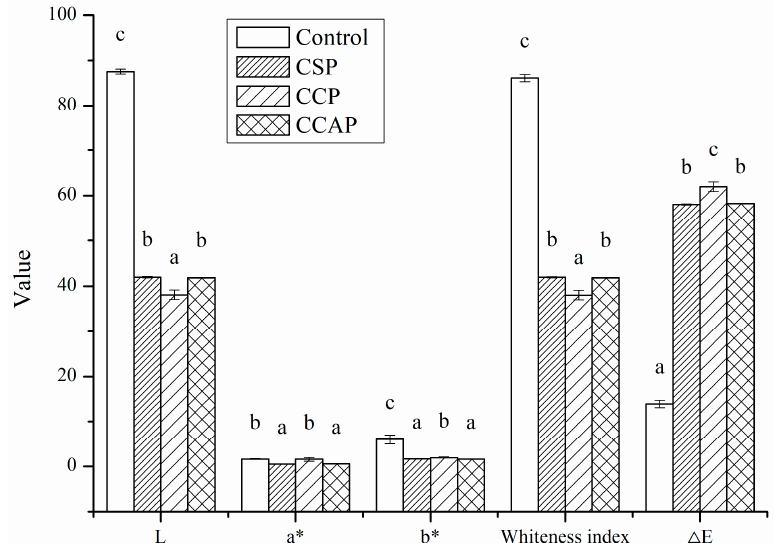
Figure 1. Color parameters ( L , a *, b *) of chitosan (control) and peptide − containing films. CSP: films from chitosan and soy protein peptides; CCP: films from chitosan and corn protein peptides; CCAP: films from chitosan and casein peptides. Results having different letters (a–c) in same pattern are significantly different ( p < 0.05).